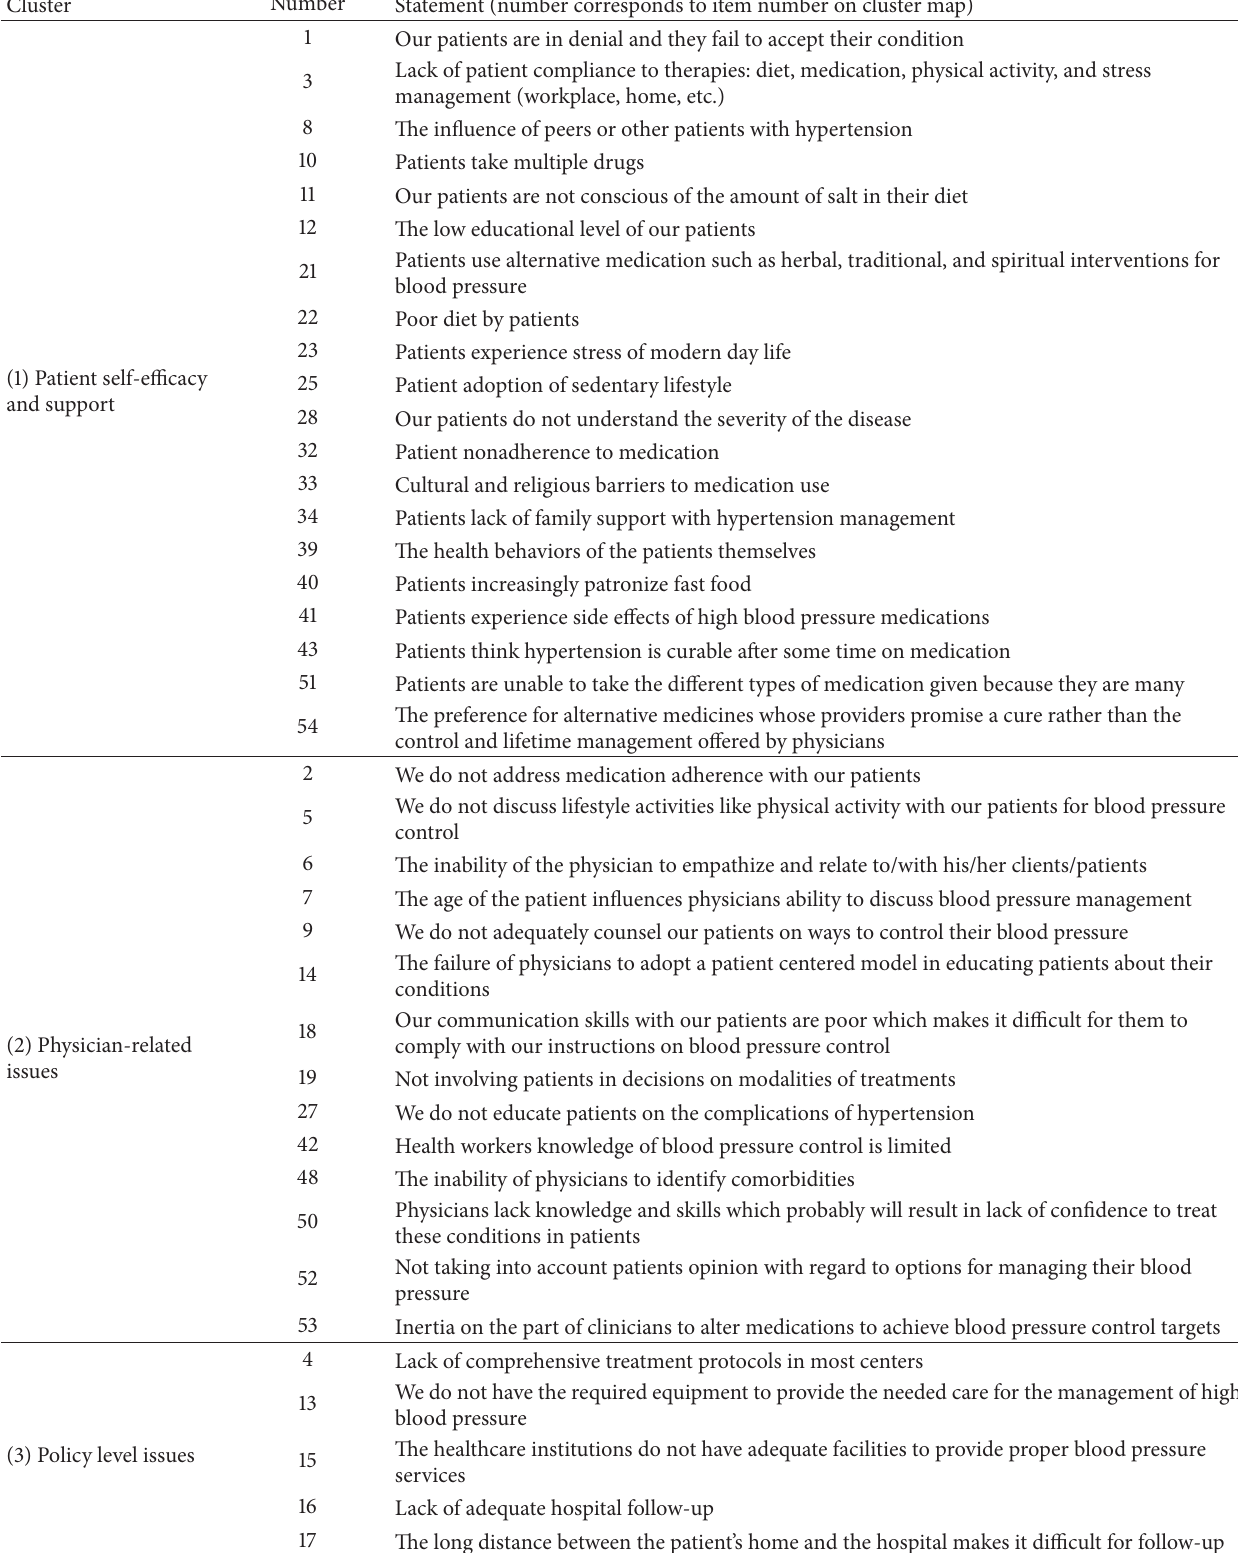
Table 1: Brainstorming statements sorted into their final